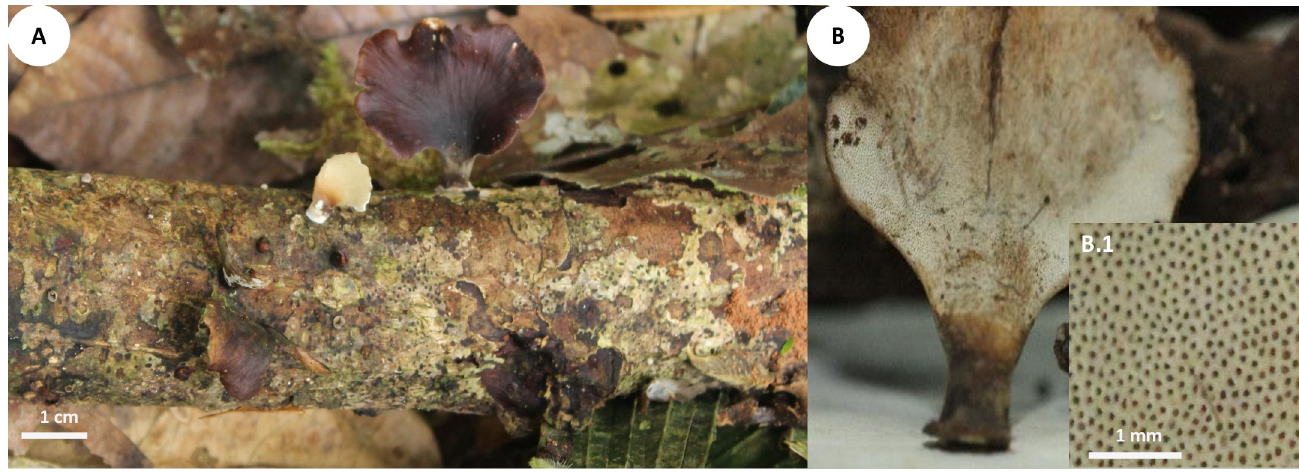
Fig 7. Basidiomata of Neodictyopus sylvaticus . A. Gregarious habit of basidiomata on substrate. B. Hymenium layer. B.1 Pore layer.